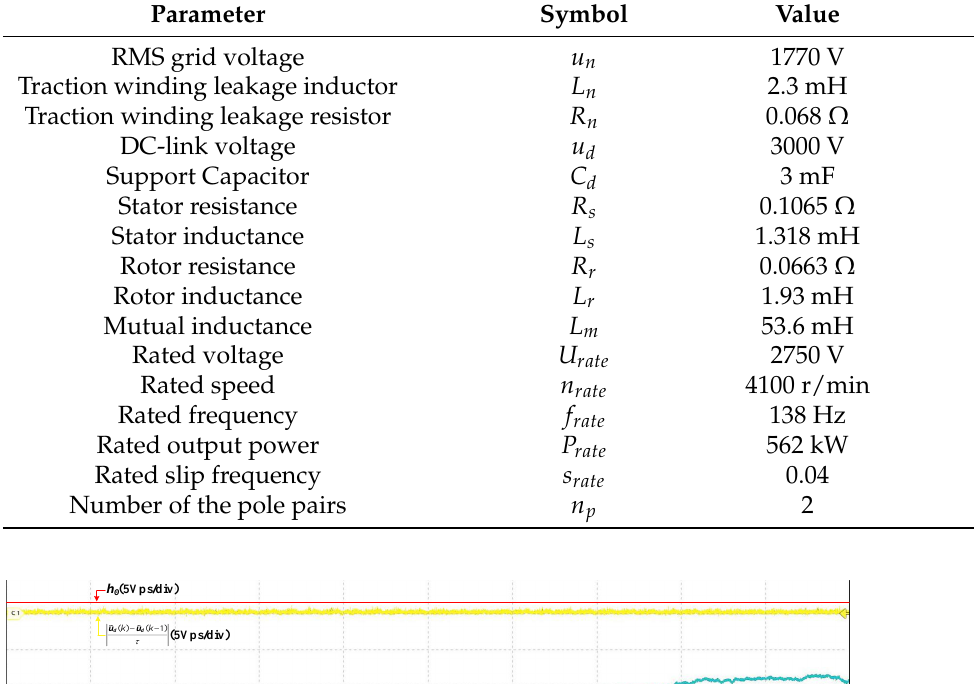
Table 2. Parameters of the system.